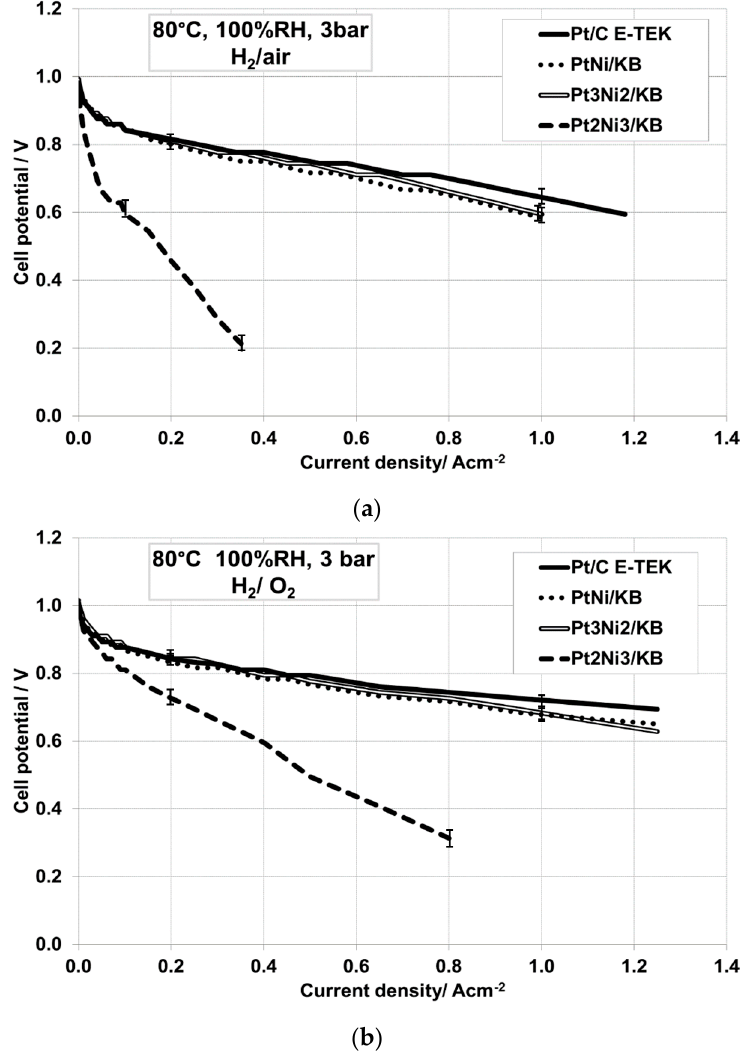
Figure 4. Polarization curves in ( a ) H 2 /air and ( b ) H 2 /O 2 among the MEAs equipped with the different cathodic PtNi catalysts and the benchmark Pt/C catalyst at 80 °C, 100% relative humidity (RH), 3 bar abs .